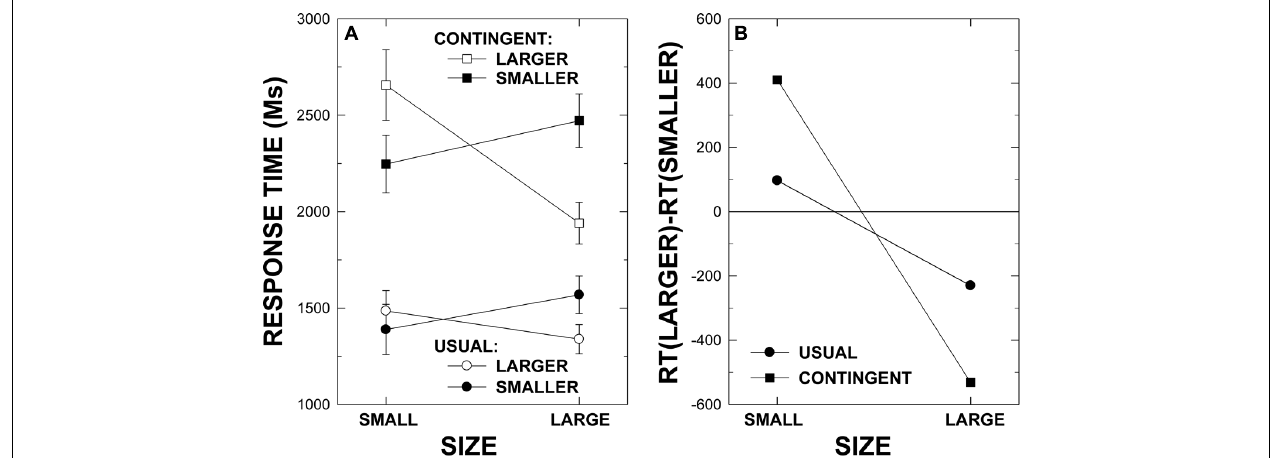
FIGURE 1 | Mean response times and standard error bars for the small and large animal size stimulus pairs with each instruction in the usual and category-contingent instruction conditions (A) in Experiment 1. The